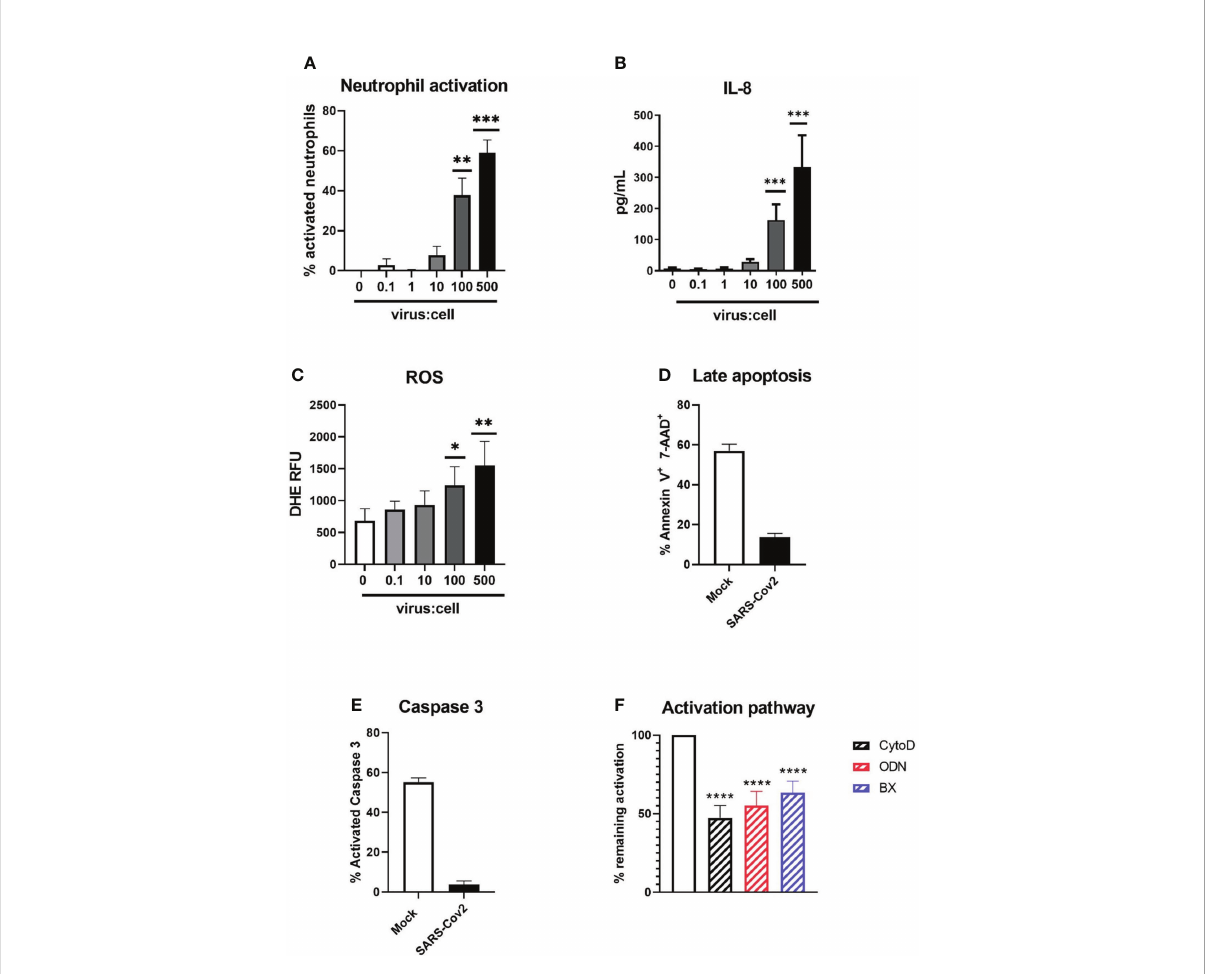
FIGURE 1 Activation of neutrophils by SARS-CoV-2 infectious particles. (A) Percentage of CD11bhigh/CD62Llow activated neutrophils after 90 min incubation of whole blood with SARS-CoV-2 ( “ Wuhan ” B. strain)(n=12). (B) Concentration of IL-8 in supernatant after incubation with SARS- CoV-2 (n=12). (C) ROS production of neutrophils after incubation with SARS-CoV-2 virus. RFU, relative fl uorescence units (n=12). (D, E) Percentage of (d) annexin V+/ 7-AAD+ late apoptotic neutrophils and (e) neutrophil expressing active caspase 3 after 18h of incubation of SARS- CoV-2 virus or medium (Mock)(n=12). (F) Percentage of inhibition of neutrophil activation by actin polymerization inhibitor cytochalasin D, TLR7 and TLR8 inhibitor ODN 2088 and STING/TLR3 signalling inhibitor BX795 (n=12). Data are mean ± SEM, *p<0.05; **p<0.01; ***p<0.001,